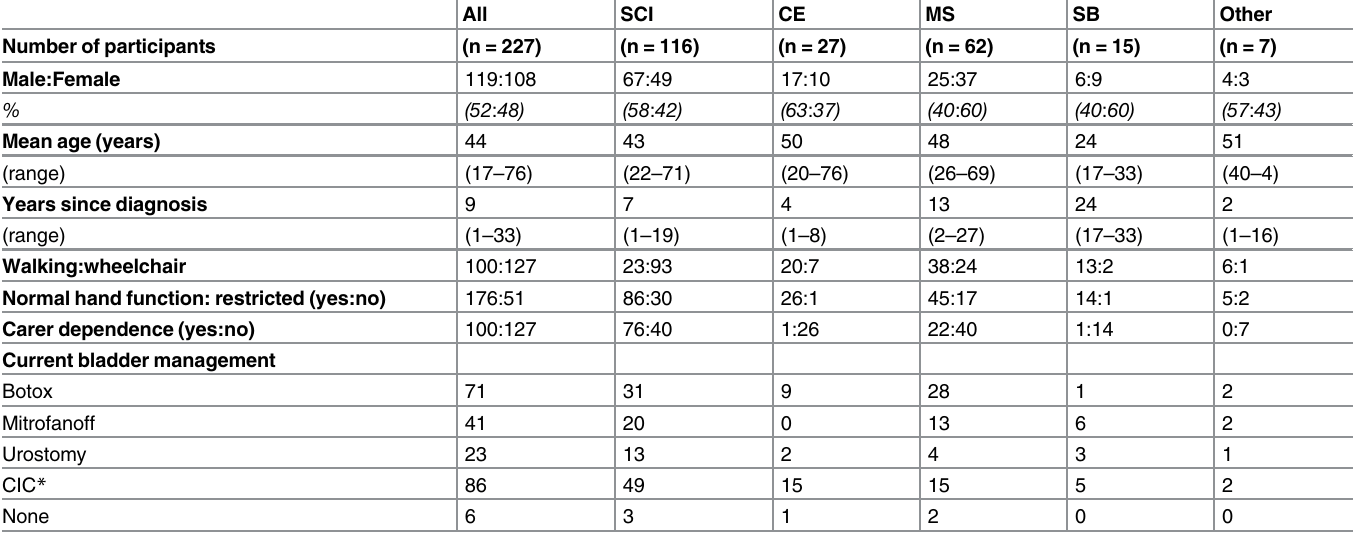
Table 2. Baseline demographics of real-life data from 227 patients.